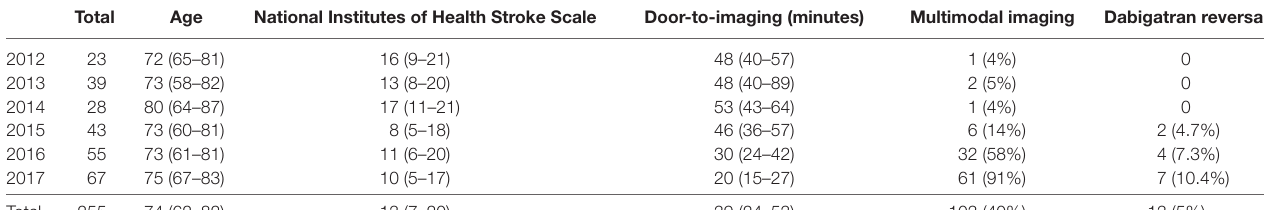
TaBle 2 | Baseline characteristics, time to imaging, use of multimodal imaging, and idarucizumab in thrombolysed patients at Christchurch